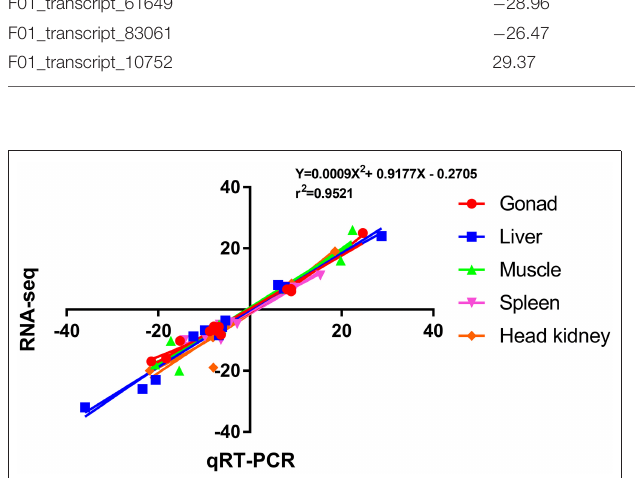
FIGURE 5 | Scatterplot of the correlation between qRT-PCR and RNA-seq. X-axis, qRT-PCR; Y-axis, RNA-seq; r2, Pearson correlation coefficient.